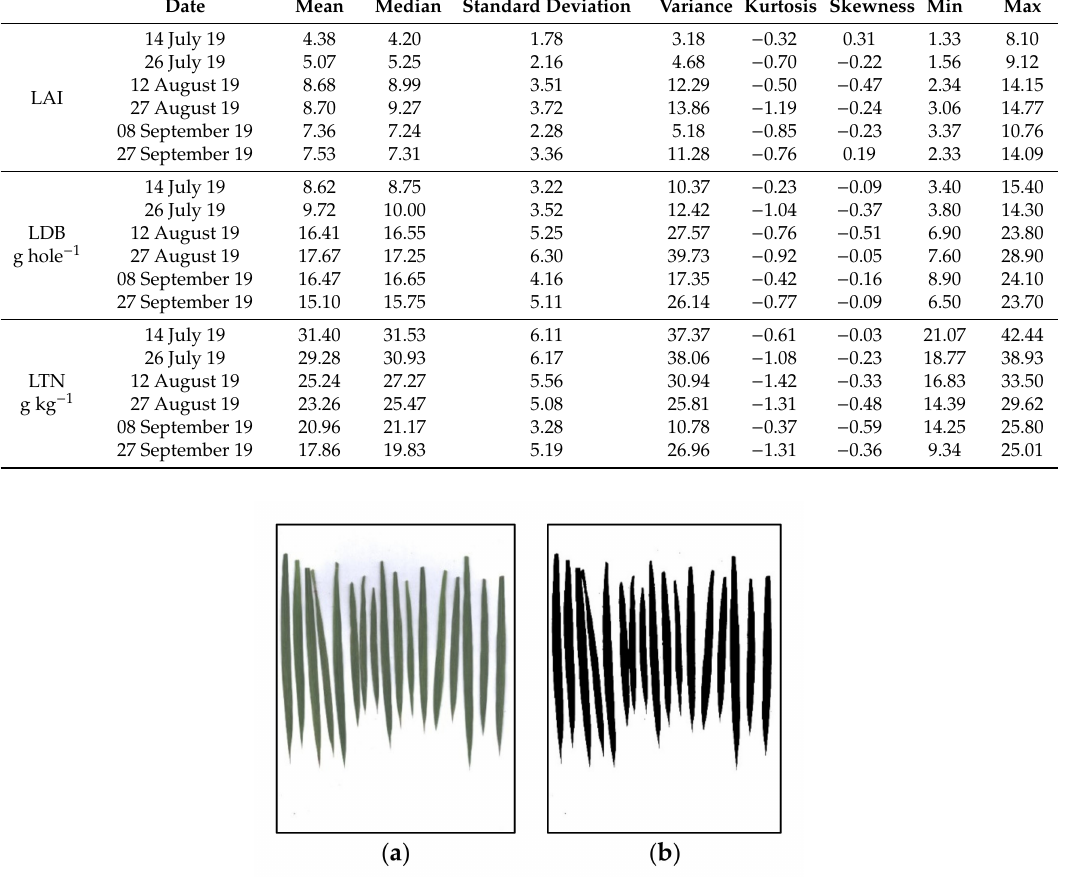
Table 2. Descriptive statistics of the growth indicators (LAI, LDB, and LTN) at di ff erent stage of rice growth.